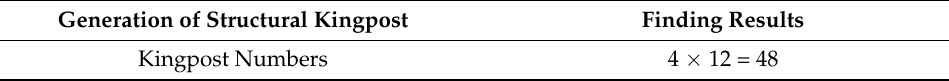
Table 7. The result of structural kingpost generation.